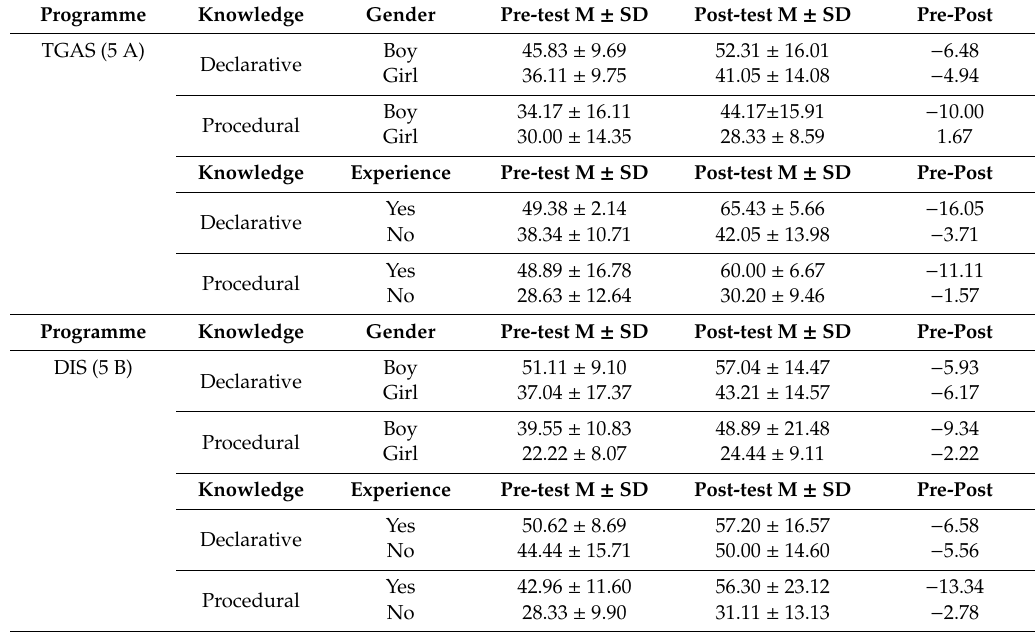
Table 3. Descriptive results of the pre-test and post-test according to gender and football